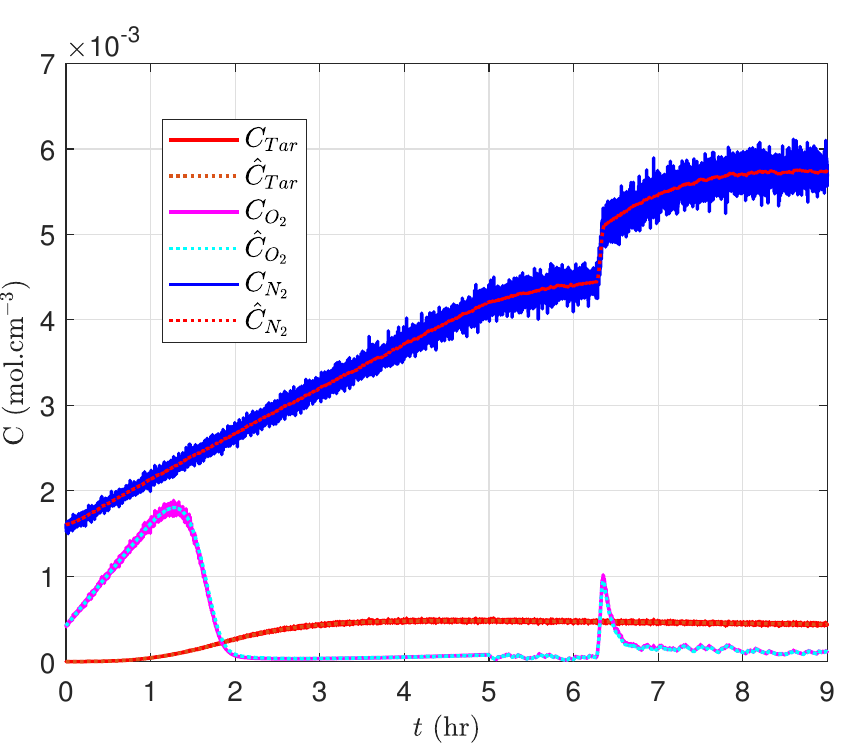
Figure 7. Measured and estimated concentrations of gases with time.